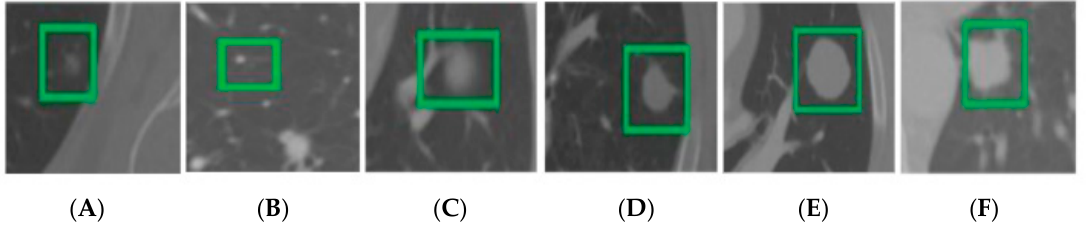
Figure 1. ( A ) Non-solid; ( B ) tiny; ( C ) partially solid; ( D ) solid; ( E ) well-circumscribed; ( F )